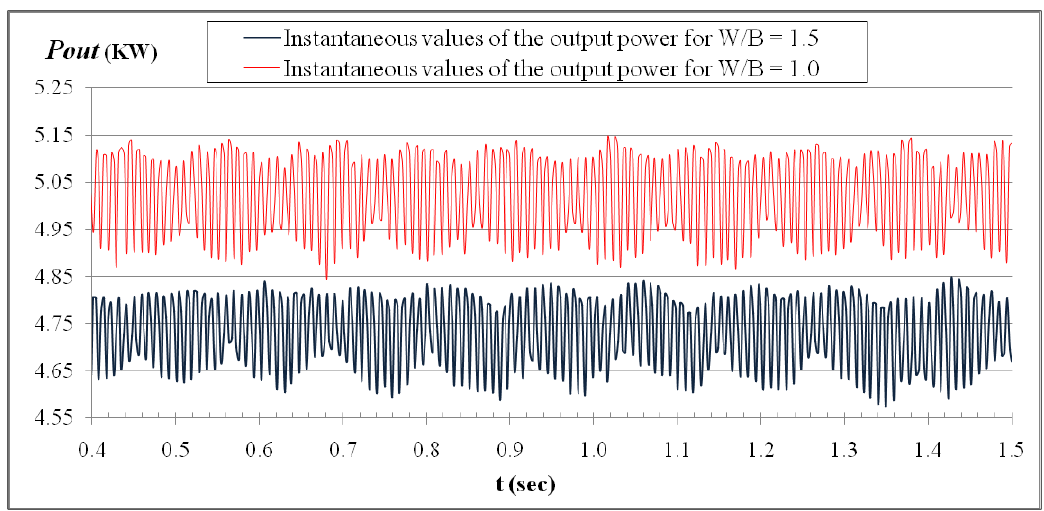
Figure 21. The instantaneous values of the output power P different values of the W/B ratio: W/B = 1.0 and W/B =